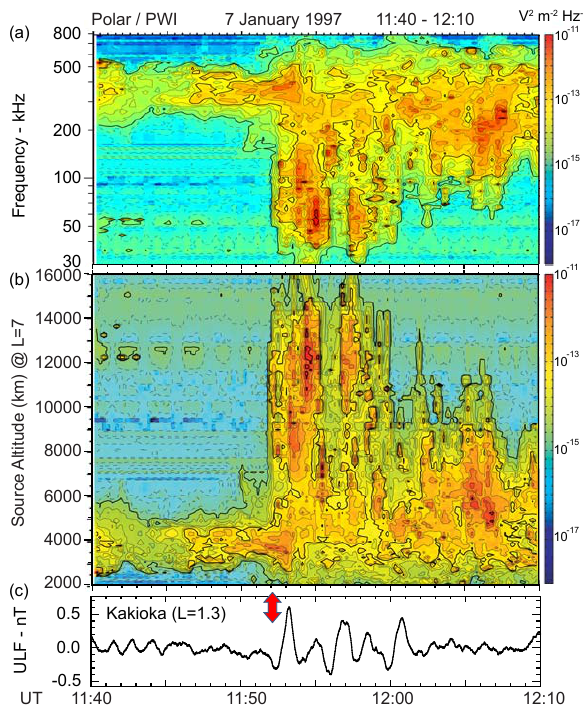
Fig. 1 Fig. 1. AKR spectrogram and Pi2 pulsation on 7 January 1997.